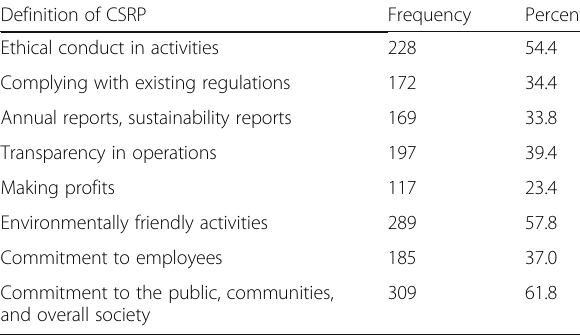
Table 2 Definition of CSRP from Respondents